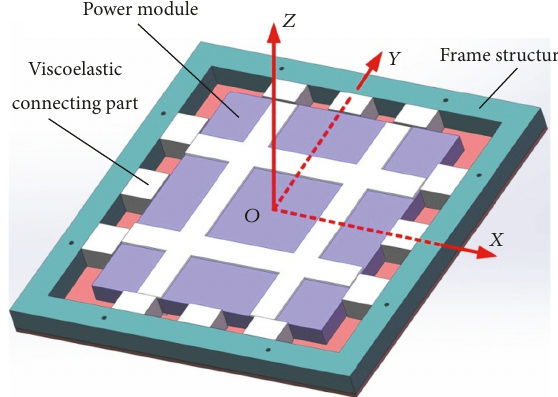
Figure 2: A quarter of the spacecraft multifunctional structure.